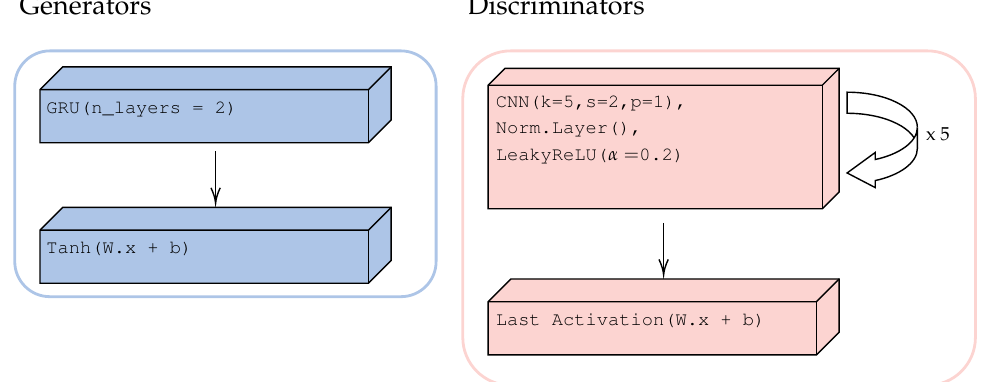
Figure 4. Generator and discriminator